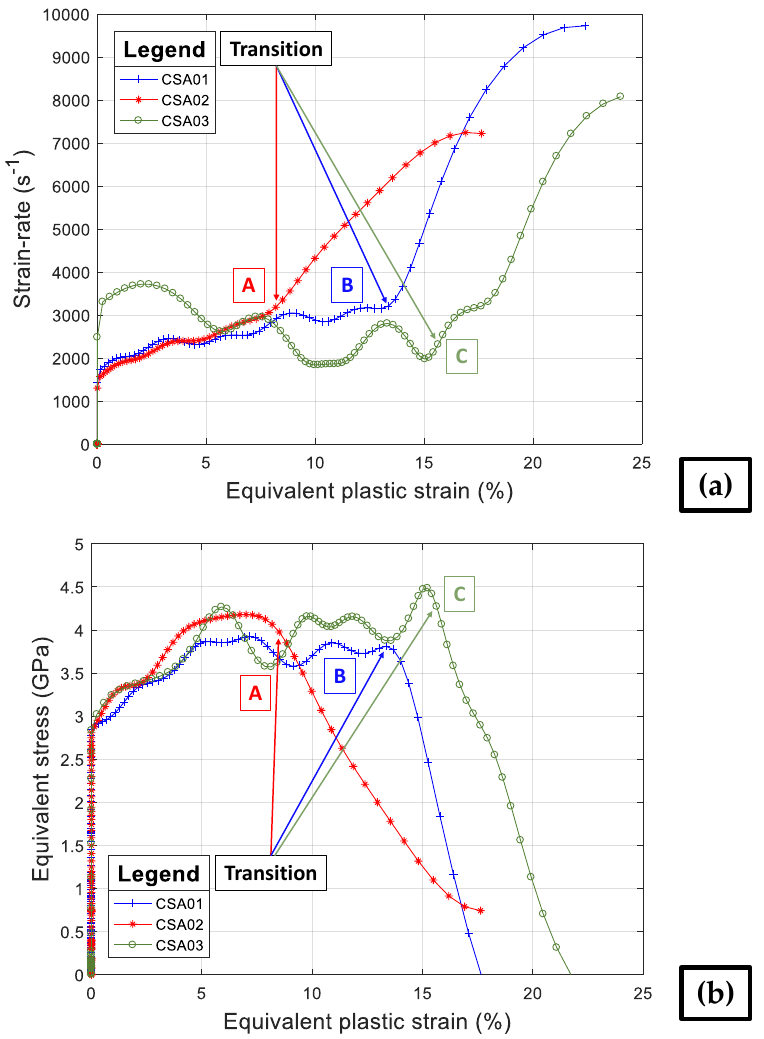
Figure 13. ( a ) Strain-rate as a function of the equivalent plastic strain for three dynamic tests, with transition points between plastic flow and failure. ( b ) Equivalent stress versus equivalent plastic strain curves for three dynamic tests.